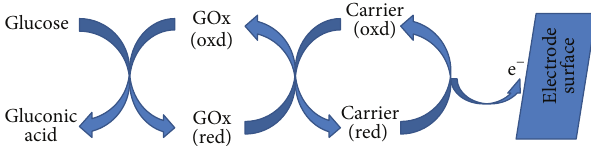
Figure 2: Diagrammatic representation of an enzyme modified electrochemical